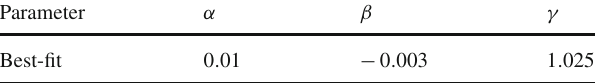
Table 1 The best-fit values for the model parameters α , β and γ